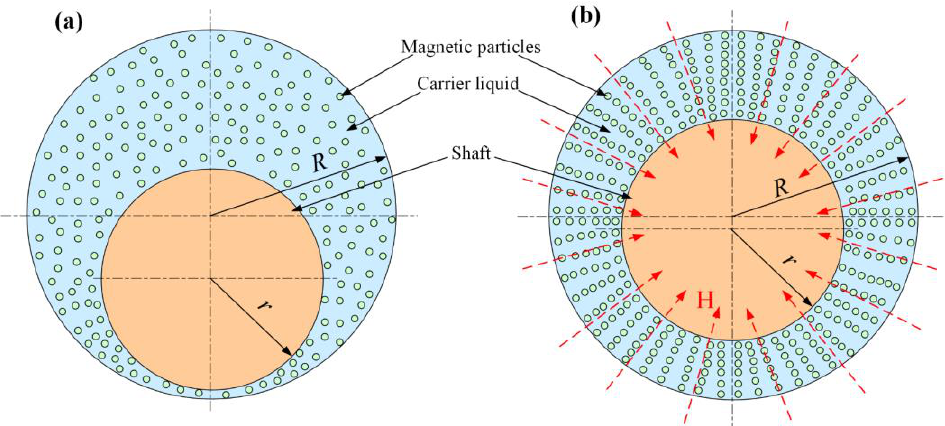
Table 1. Basic parameters of the structure of bearing friction pairs.